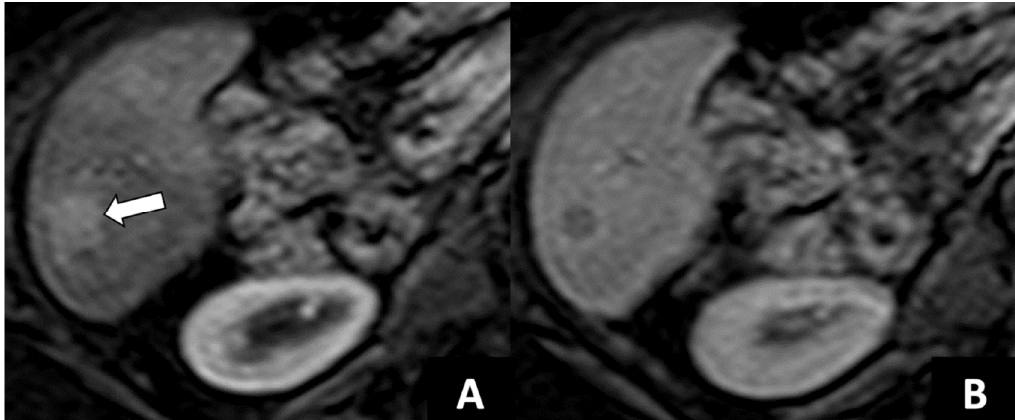
Figure 2. 77-year-old woman with history of cirrhosis who achieved sustained virologic response with direct acting antiviral therapy. Contrast-enhanced MRI shows ( A ) a 1.2 cm observation (arrow) with nonrim arterial phase hyperenhancement, and ( B ) nonperipheral washout on portal venous phase, consistent with de novo hepatocellular carcinoma.